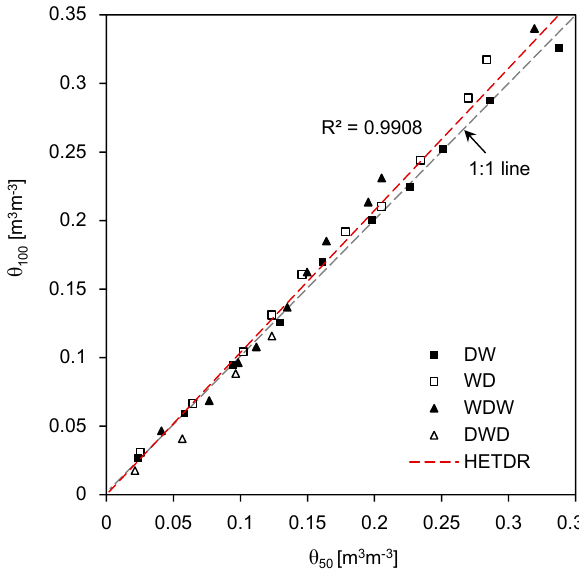
Figure 16. Relationship between the SWCs estimated using probes with lengths of 50 cm and 100 cm. θ 50 and θ 100 denote the SWCs estimated from the probes with lengths of 50 cm and 100 cm, respectively.